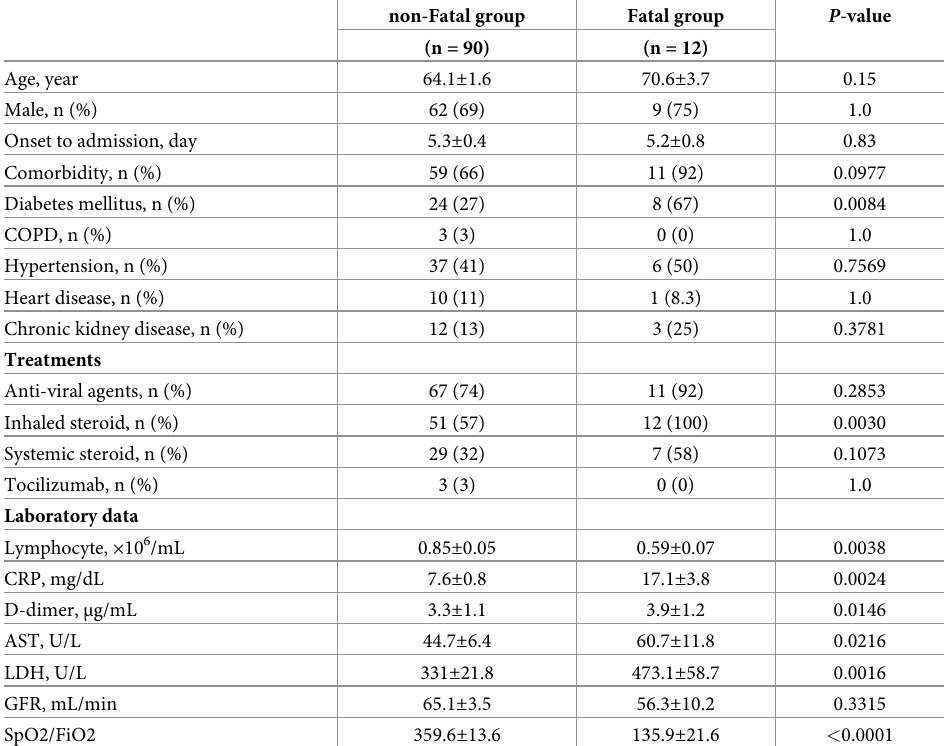
Table 2. Comparisons of clinical, laboratory, and therapeutic features between non-Fatal group and Fatal group. non-Fatal group Fatal group P